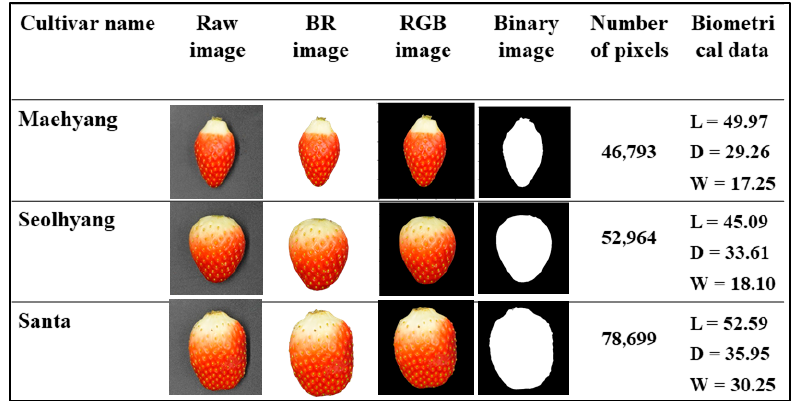
Figure 3. Strawberry fruit images with raw image, background removal image (BR), RGB image, and binary image of the three different cultivars. Pixel numbers of images and their biometrical data; L: length (mm), D: diameter (mm), W: weight (g) are respectively shown in the rightmost two columns.